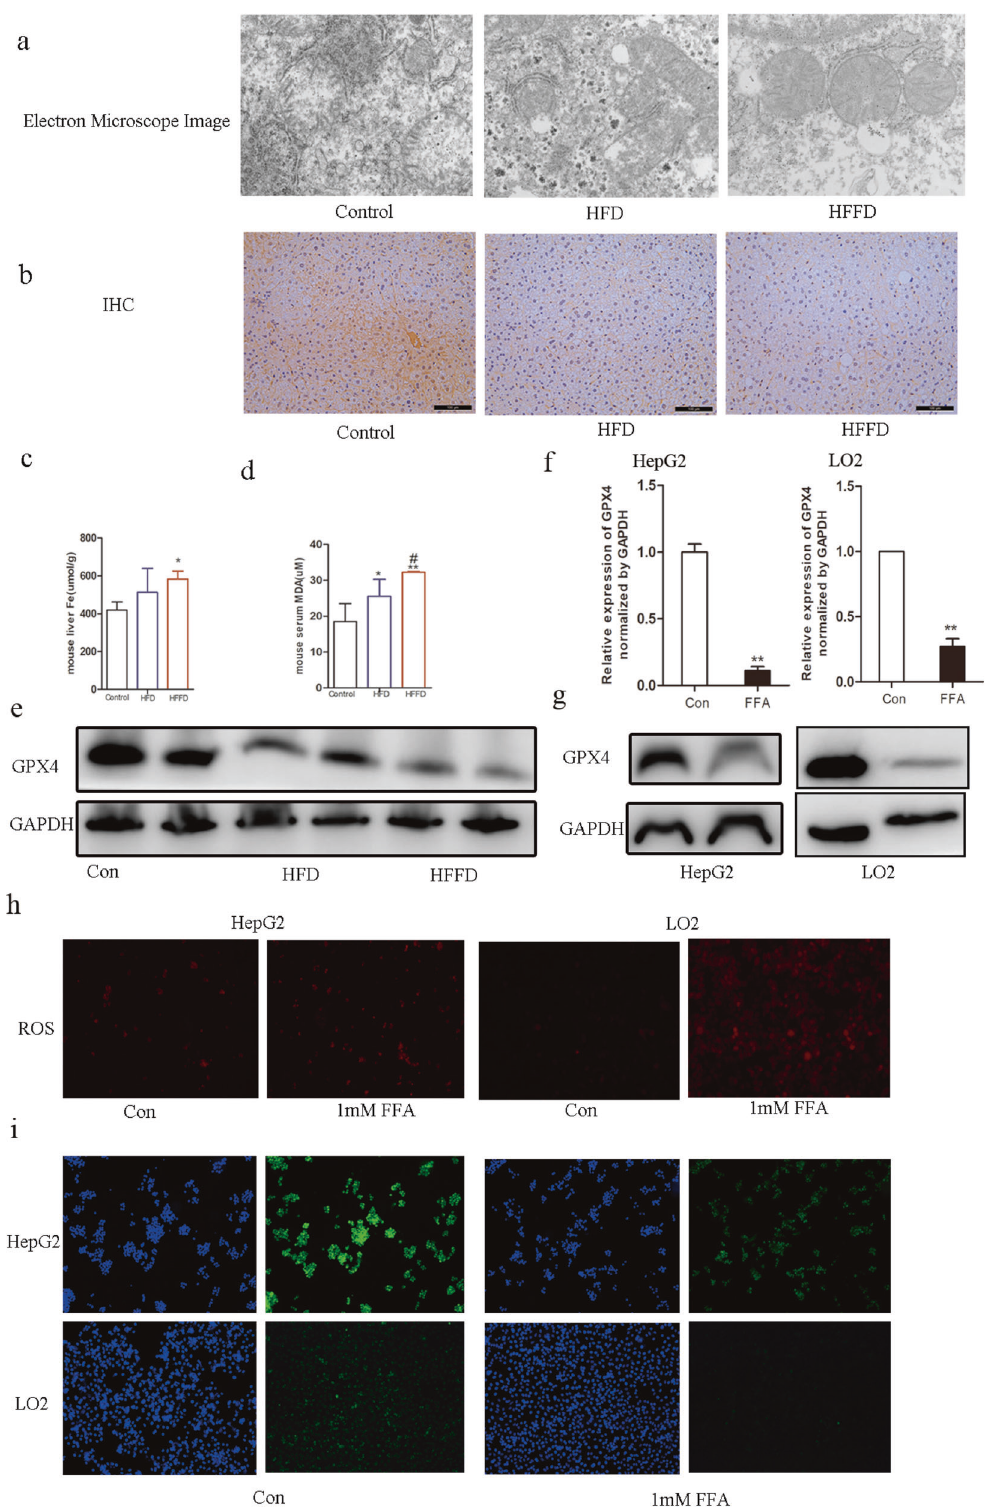
Fig. 3 Ferroptosis in mice with NAFLD and FFA-induced hepatocytes. a Electron microscope image of the liver in mice with HFD, HFFD, or a regular chow diet. b IHC analysis of GPX4 expression of the liver in mice with HFD, HFFD, or regular chow diet. c Liver Fe in mice with HFD, HFFD, or regular chow diet. d Serum MDA in mice with HFD, HFFD, or regular chow diet. e Western blot analysis of GPX4 levels in mice with HFD, HFFD, or regular chow diet. f Relative mRNA expression levels of GPX4 in FFA-induced HepG2 and LO2 cells, **compared to control, p < 0.001. g Western blot analysis of GPX4 levels in FFA-induced HepG2 and LO2 cells. h ROS expression in FFA-induced HepG2 and LO2 cells. i IF of GPX4 expression in FFA-induced HepG2 and LO2 cells.